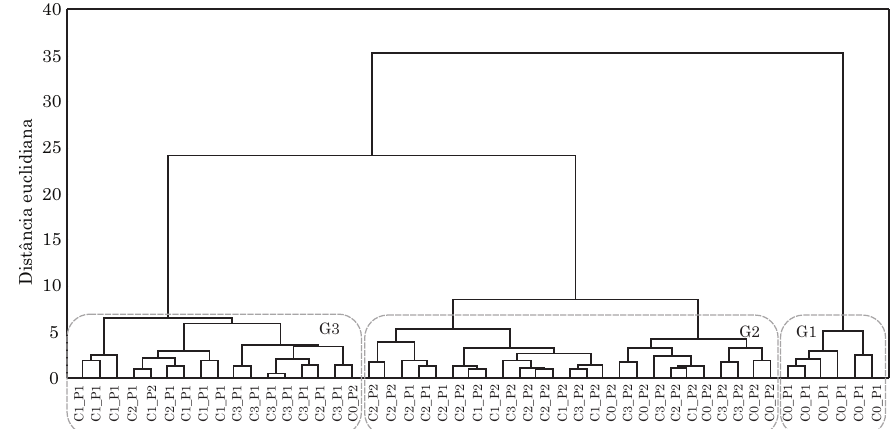
Figura 3. Dendrograma resultante da análise de agrupamento por método hierárquico evidenciando a formação de grupos G1, G2 e G3 dos acessos nas profundidades P1: 0-0,10 e P2: 0,10-0,20 m e nos solos C 0 : solo não trafegado; C 1 : duas passadas; C 2 : quatro passadas; e C 3 : seis passadas de trator de 11 Mg.